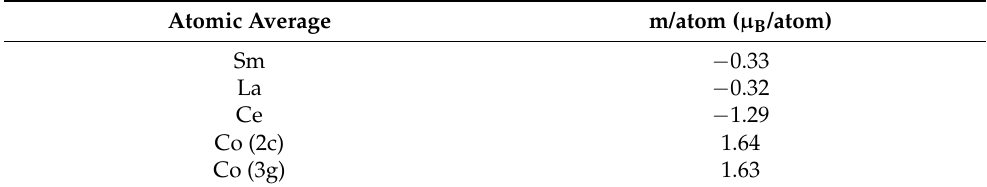
Figure 4. Atomic contribution to the electronic DOS for RE atoms (Ce, La, Sm) and Co (2c and 3g sites) as calculated from the ab initio simulations. Table 2. Average magnetic moments for each atomic species as calculated from the ab initio simulations for the case of the sample with x = 0.5.